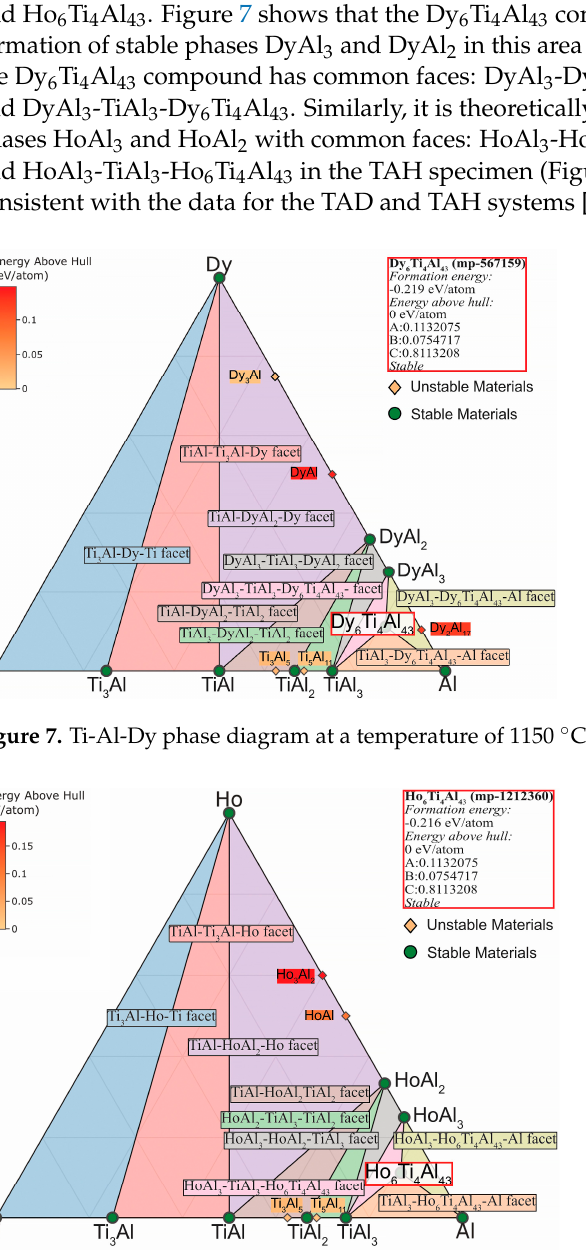
Figure 6. TEM patterns of the TAD alloy, selected area electron diffraction (SAED) patterns of the TAD alloy in the relevant region (1)–(4).